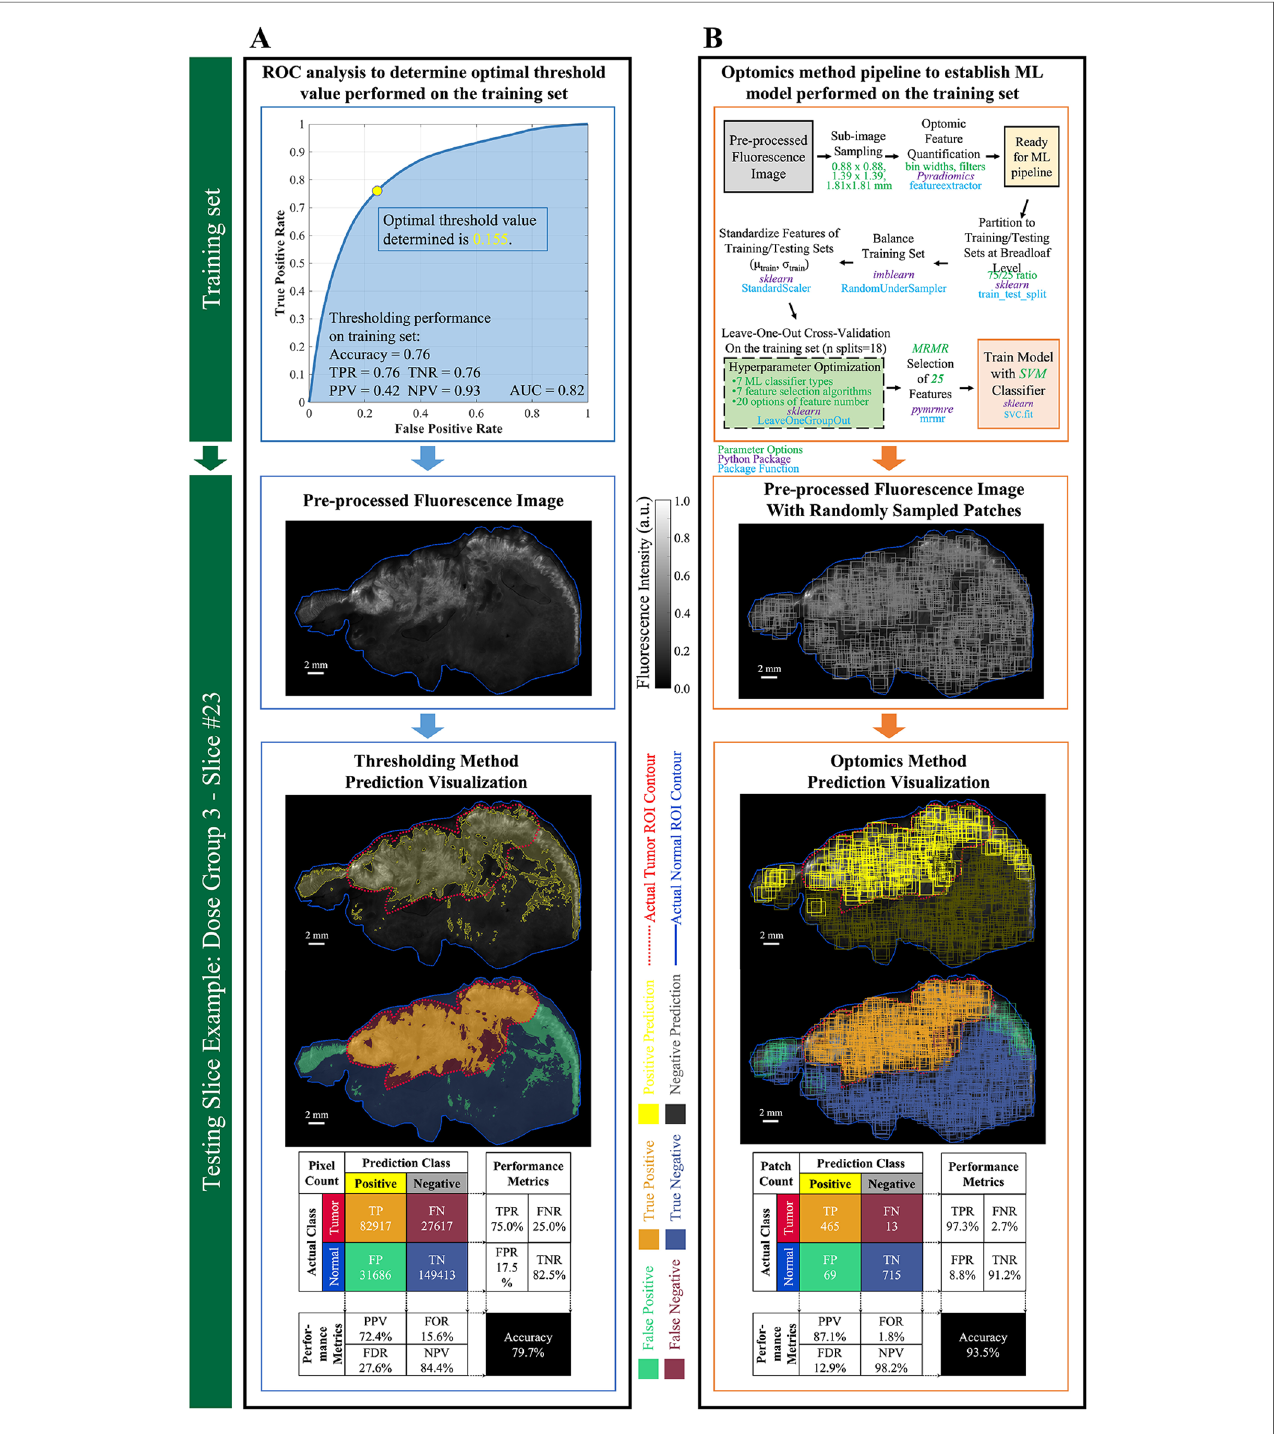
FIGURE 6 Performance evaluation of thresholding vs. optomics methods. ( A ) Thresholding method and its classi fi cation performance. The optimum cutoff point (i.e., threshold value) was determined through ROC curve analysis on the training set, and its predictive performance was assessed on the testing set. Pixel-level classi fi cation of the thresholding method is visualized on a testing slice example. Metrics describing its predictive performance on this testing slice example are summarized in the confusion matrix. ( B ) Optomics method and its classi fi cation performance. The ML model was determined based on the training set and a supervised ML pipeline summarized in the fl ow chart. Patch-level classi fi cation of the optomics method is visualized on the same testing slice, and its predictive performance is summarized in the confusion